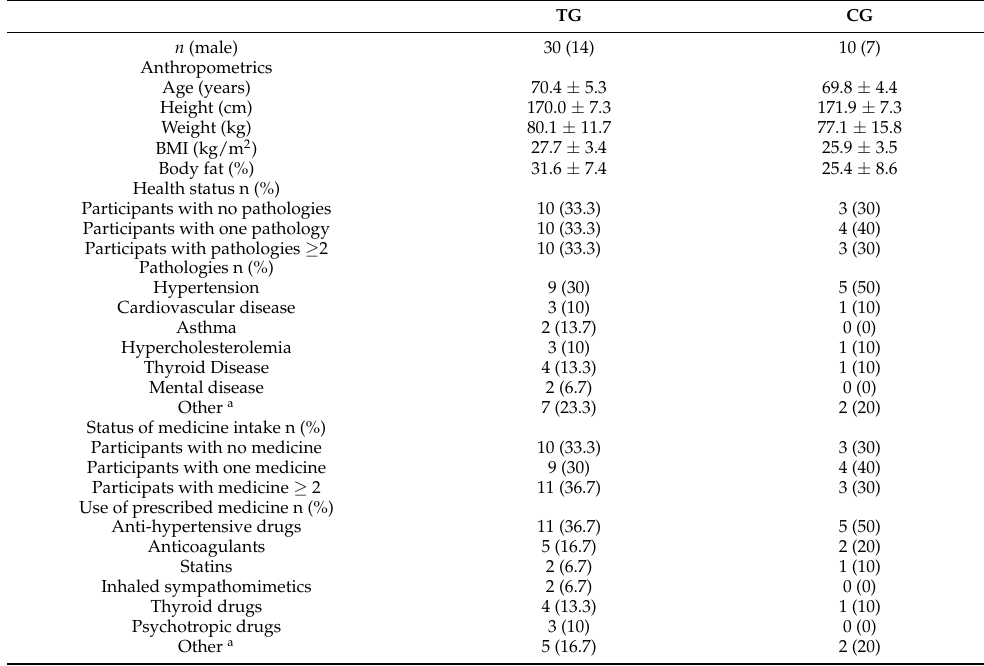
Table 1. Anthropometric and health status of Training Group (TG) and Control Group (CG) (mean ±